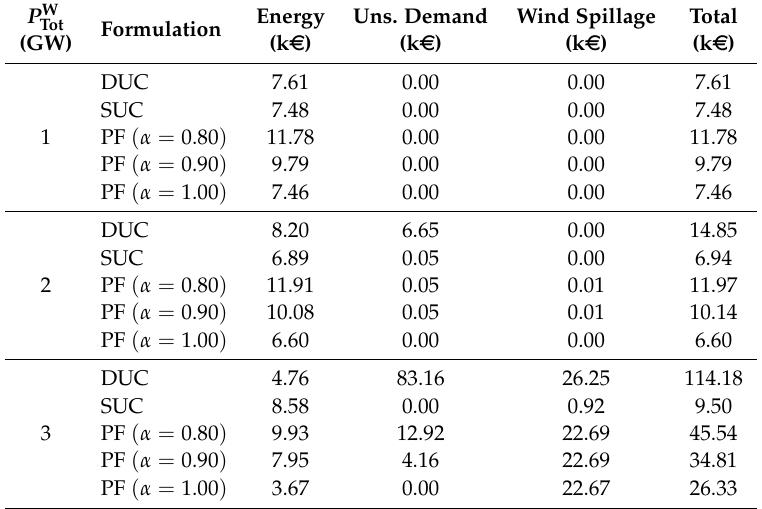
Table 4. Expected balancing